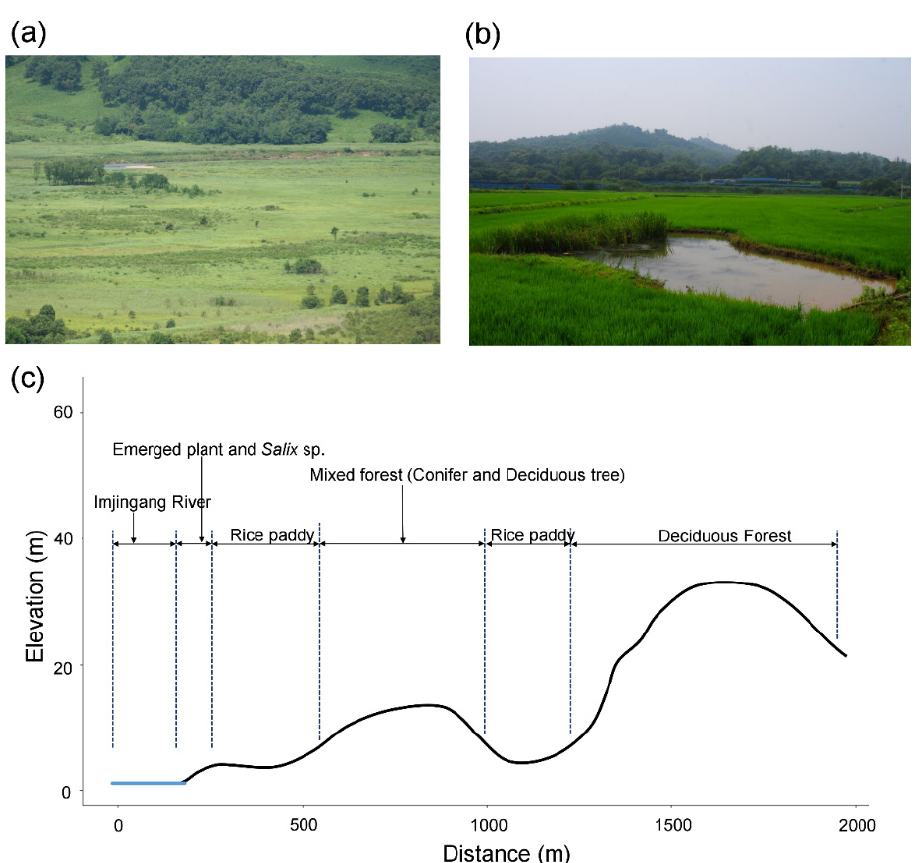
Figure 2. Landscape of western DMZ and CCZ in Paju. Typical topography and composition of vegetation. ( a ) Grassland and forest areas in western DMZ (photograph by Seung Ho Kim). ( b ) Agricultural landscape, including dumbeong , a traditional irrigation pond, in western CCZ (photograph by Jae Hyun Kim). ( c ) Topographical map of the western CCZ. Landscape mainly consists of emergent plants and Salix species in the riverside, rice paddies, and forests.